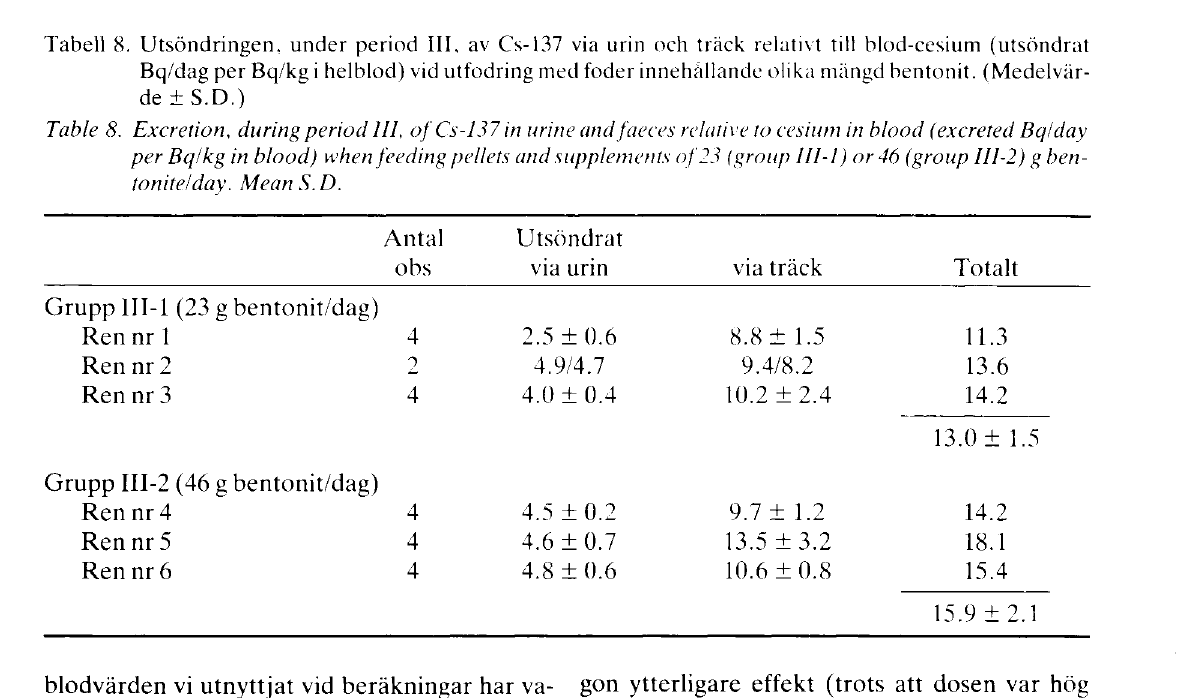
Tabell 8. Utsondringen, under period III, av Cs-137 via urin och track relativt till blod-cesium (utsondrat de±S.D.) Table 8. Excretion, during period III, of Cs-137 in urine and faeces relative to cesium in blood (excreted Bqlday per Bq/kg in blood) when feeding pellets and supplements of 23 (group III-l) or 46 (group 111-2) g ben- tonitelday. Mean S.D.